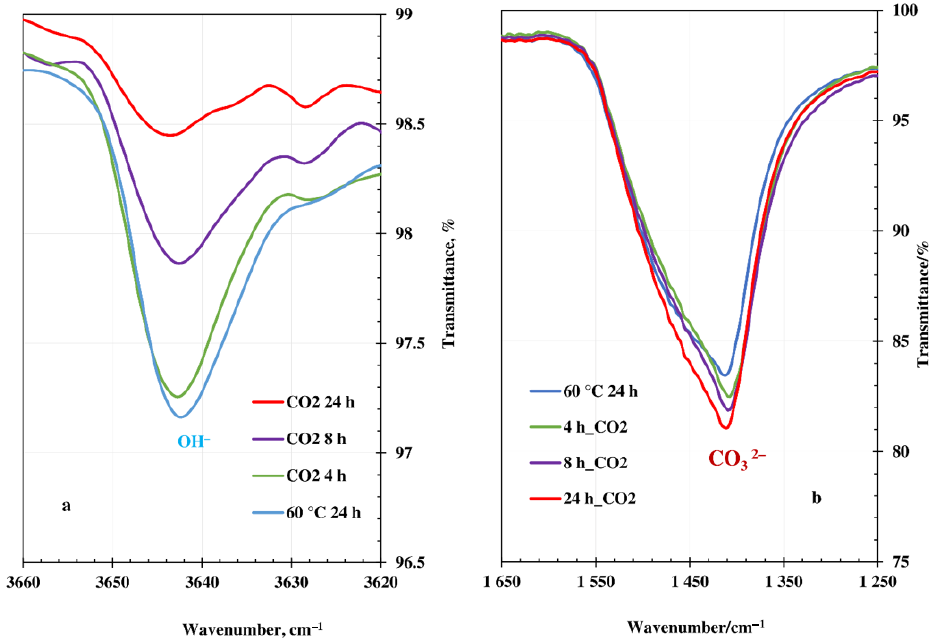
Figure 11. FTIR spectra of granulated samples stored in CO 2 atmosphere (15%) in the. wavenumber region characteristic to OH − 1 ( a ) and CO 3 − 2 ( b ). The most significant was the decrease of SO 42 − —for cyclon ash 25% (from 634 mg L − 1 down to 466 mg L − 1 ) and 70%, (down to 195 mg L − 1 ) and for ESPA 37% (from 1090 mg L − 1 down to 695 mg L − 1 ) and 53% (down to 515 mg L − 1 ), respectively, dried immediately at 60 ◦ C or after storing in an atmosphere containing 15% CO 2